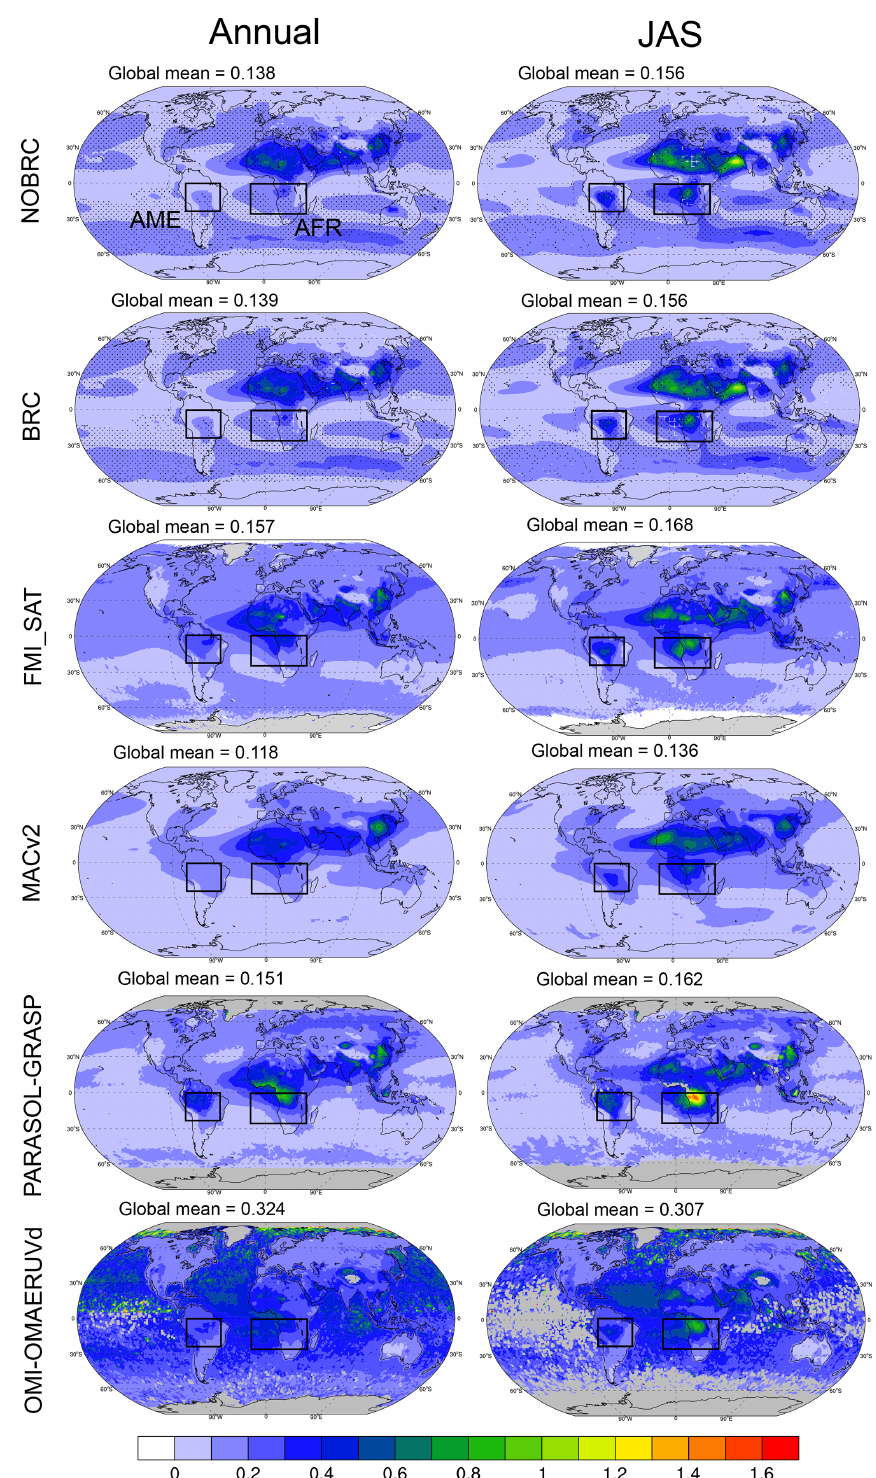
Figure A5. Same as Fig. 8 but for the AOD (550nm; see Tables 2 and 3 for details). FMI_SAT has also been added here.